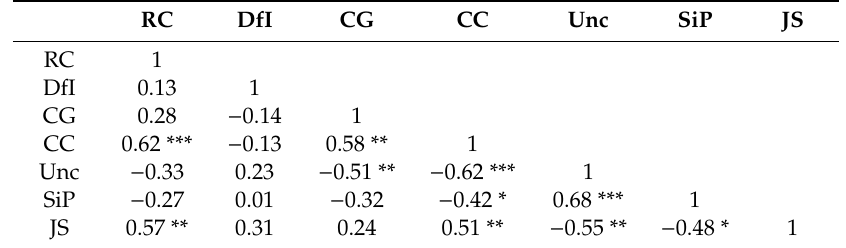
Table 5. Pearson correlations among the RPQ subscales for the MSBS students in December 2018. RC DfI CG CC Unc SiP JS RC 1 DfI 0.17 1 CG 0.42 * − 0.29 1 CC 0.70 *** − 0.08 0.43 * 1 Unc 0.22 0.55 ** − 0.04 0.00 1 SiP 0.29 0.39 * − 0.07 0.12 0.84 *** 1 JS 0.20 − 0.09 0.06 0.17 − 0.52 ** − 0.50